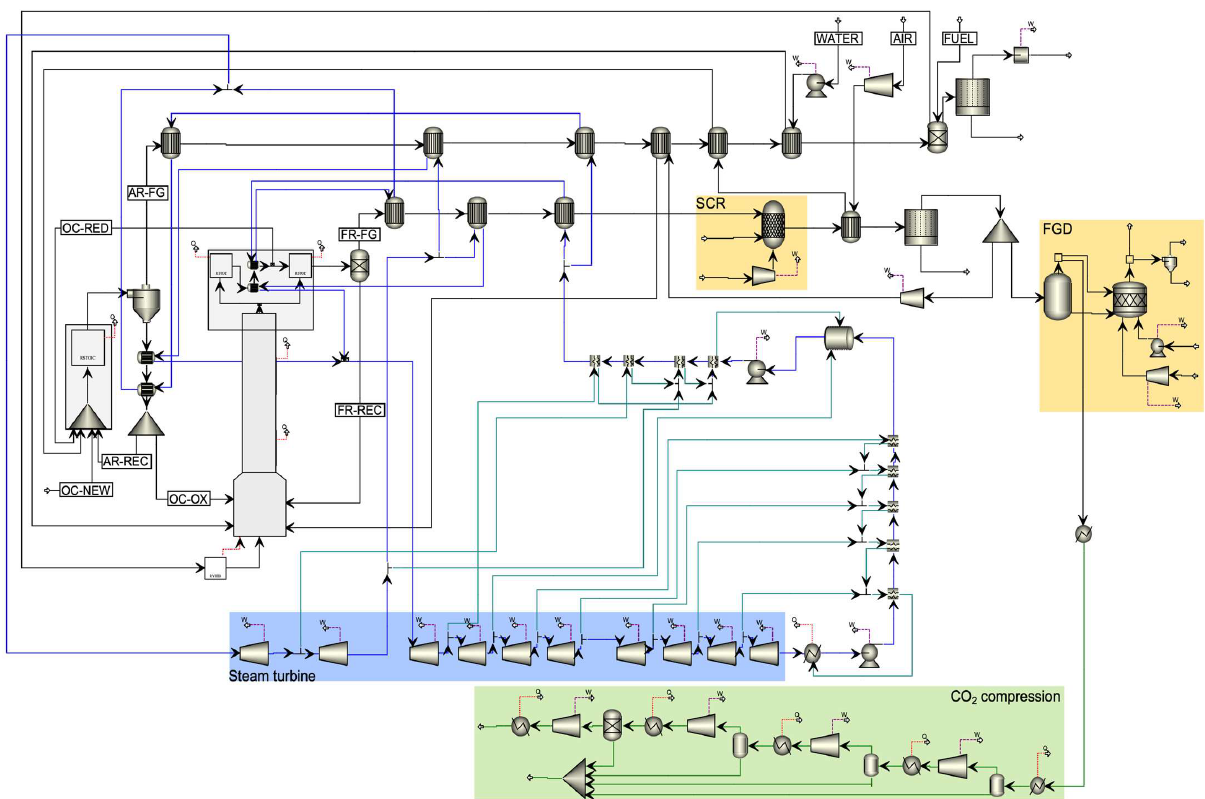
Figure 3. Flowsheet representation of the considered CLC power plant.